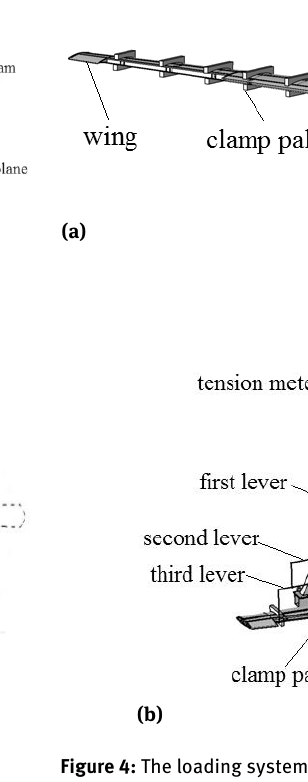
Figure 3: Schematic diagram of wing-fuselage connection